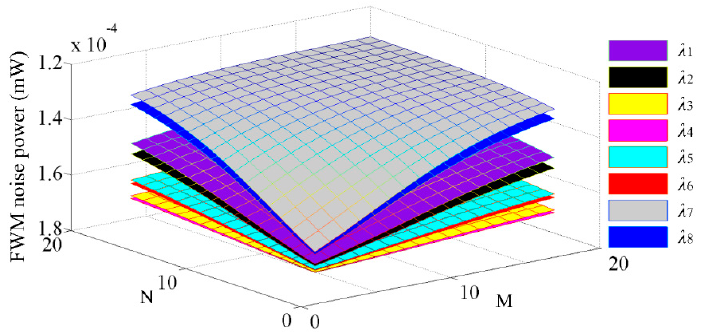
Figure 7. The FWM noise power at different wavelengths in M×N WDM-based torus